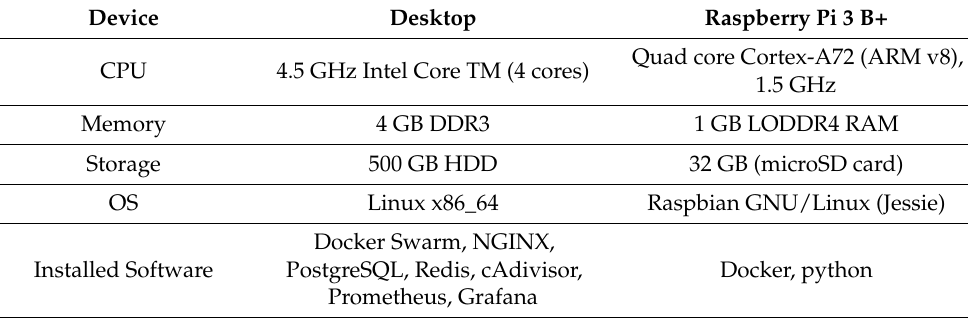
Table 1. Configuration of the experimental